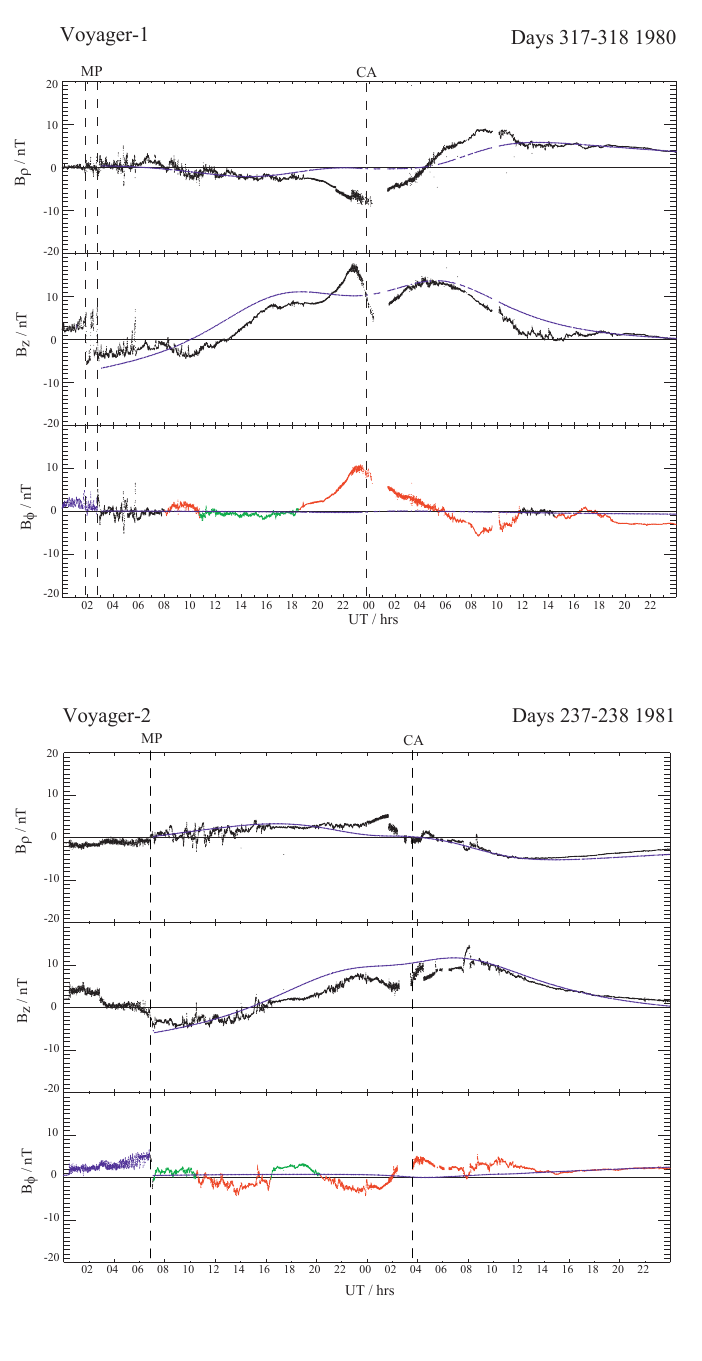
Fig. 8. As for Fig. 7, except for